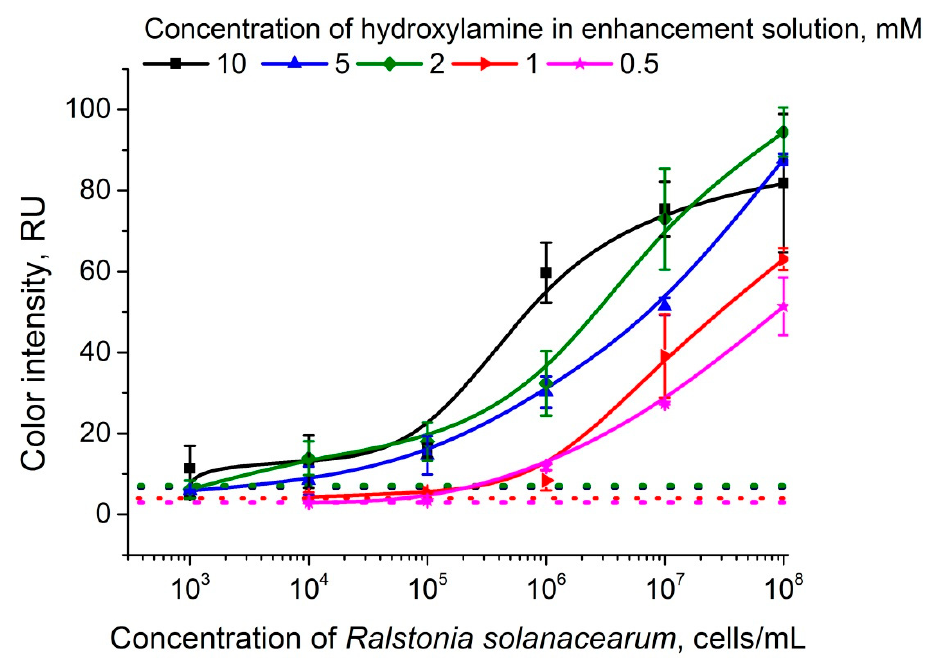
Figure 4. Calibration curves of R. solanacearum after enlargement with the enhancement solutions with different hydroxylamine concentrations. The dotted line corresponds to the LOD level.